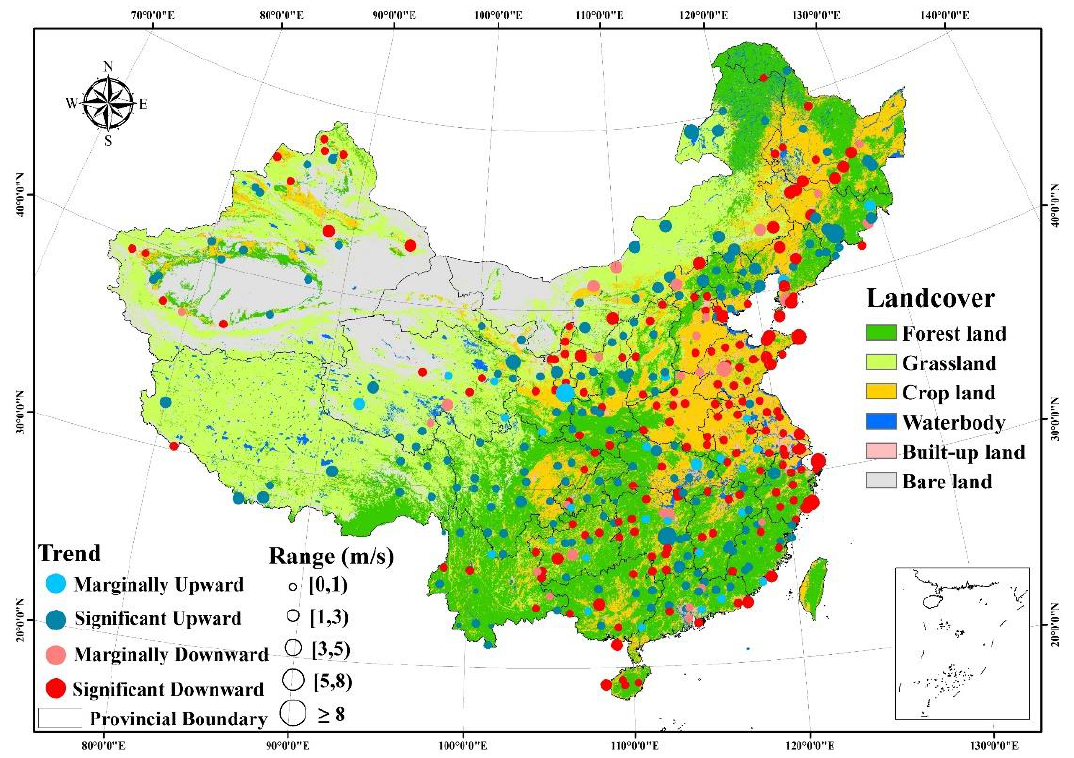
Figure 10. Spatial distribution of different wind speed ranges for the land covers of China from 2000 to 2019.